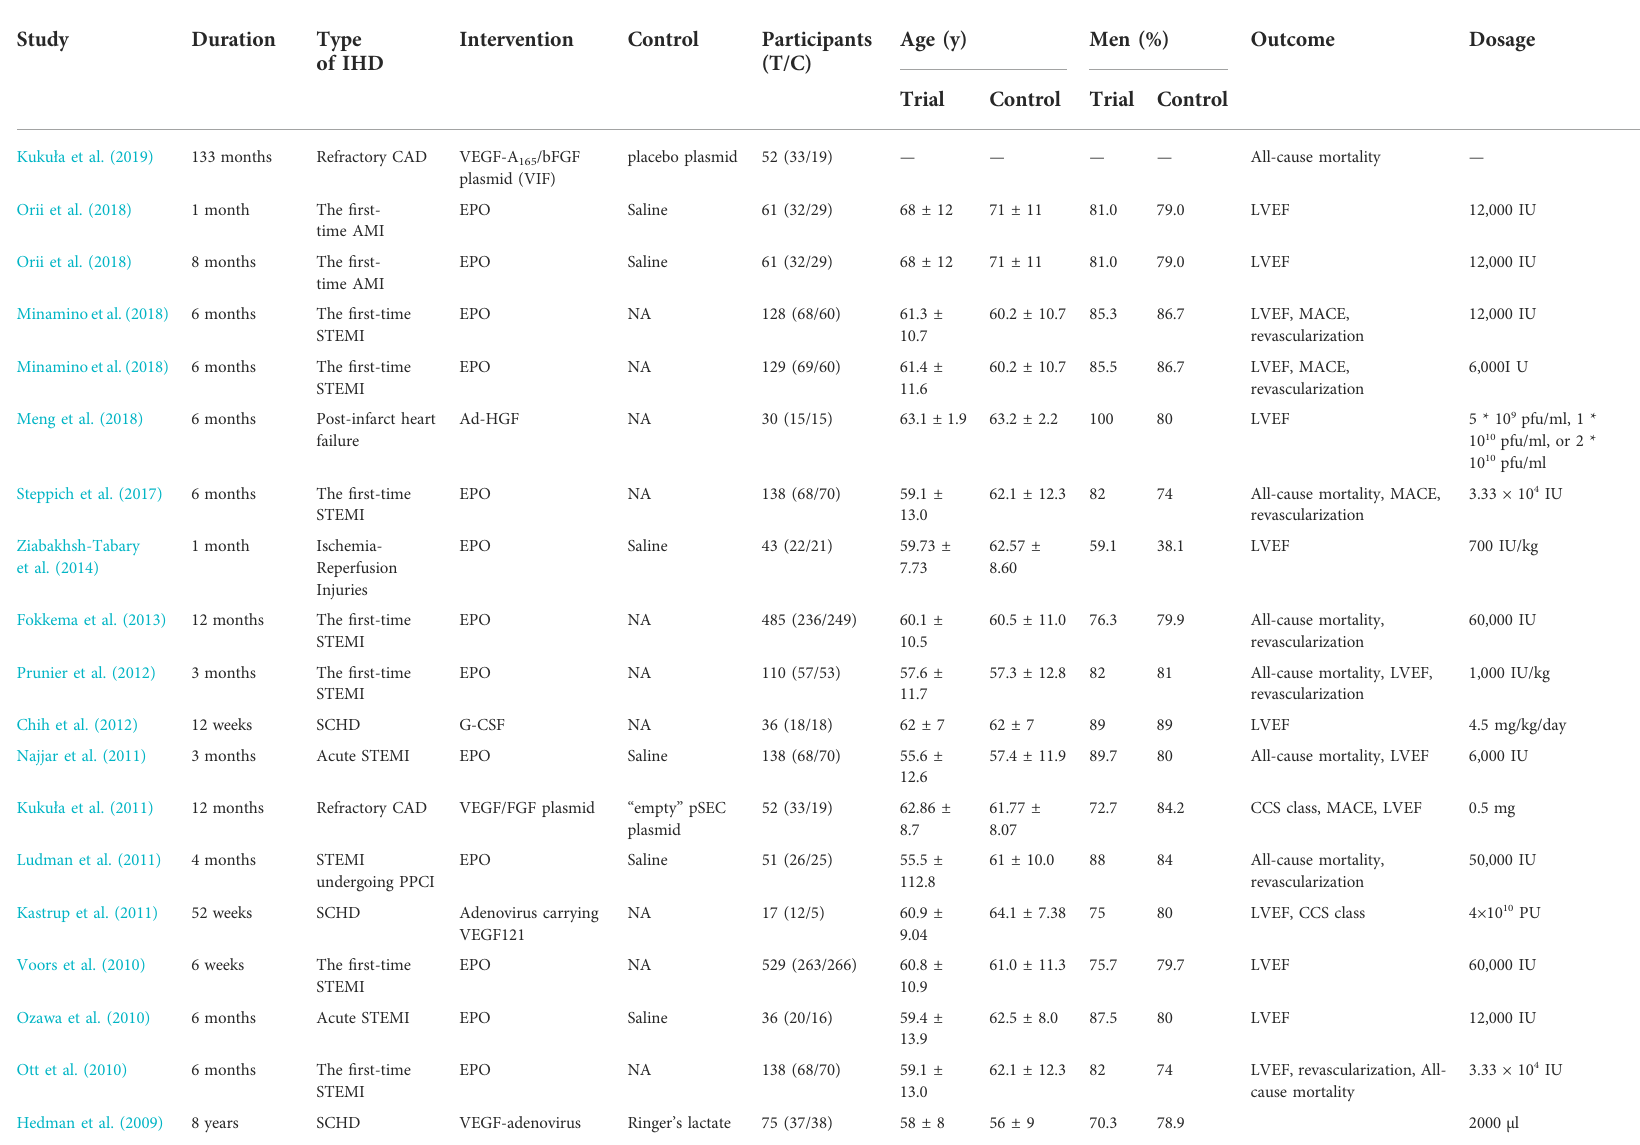
TABLE 1 Basic characteristics of